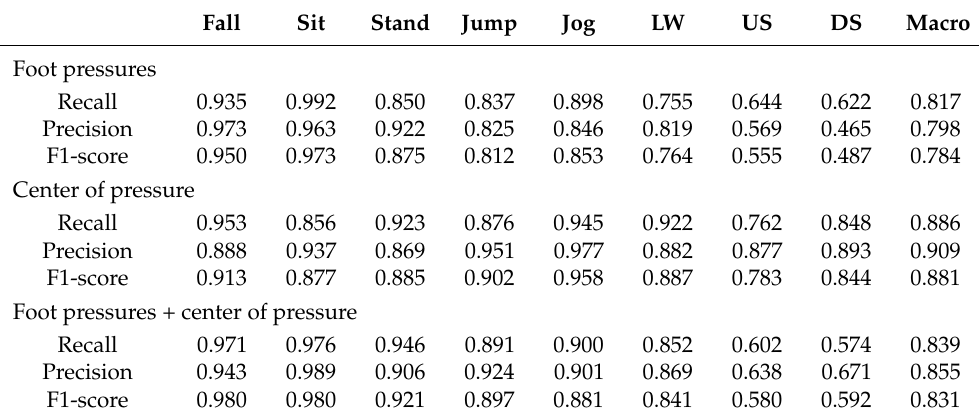
Table 4. Results on the detections of fall and physical activities based on foot pressures and center of pressure obtained from both